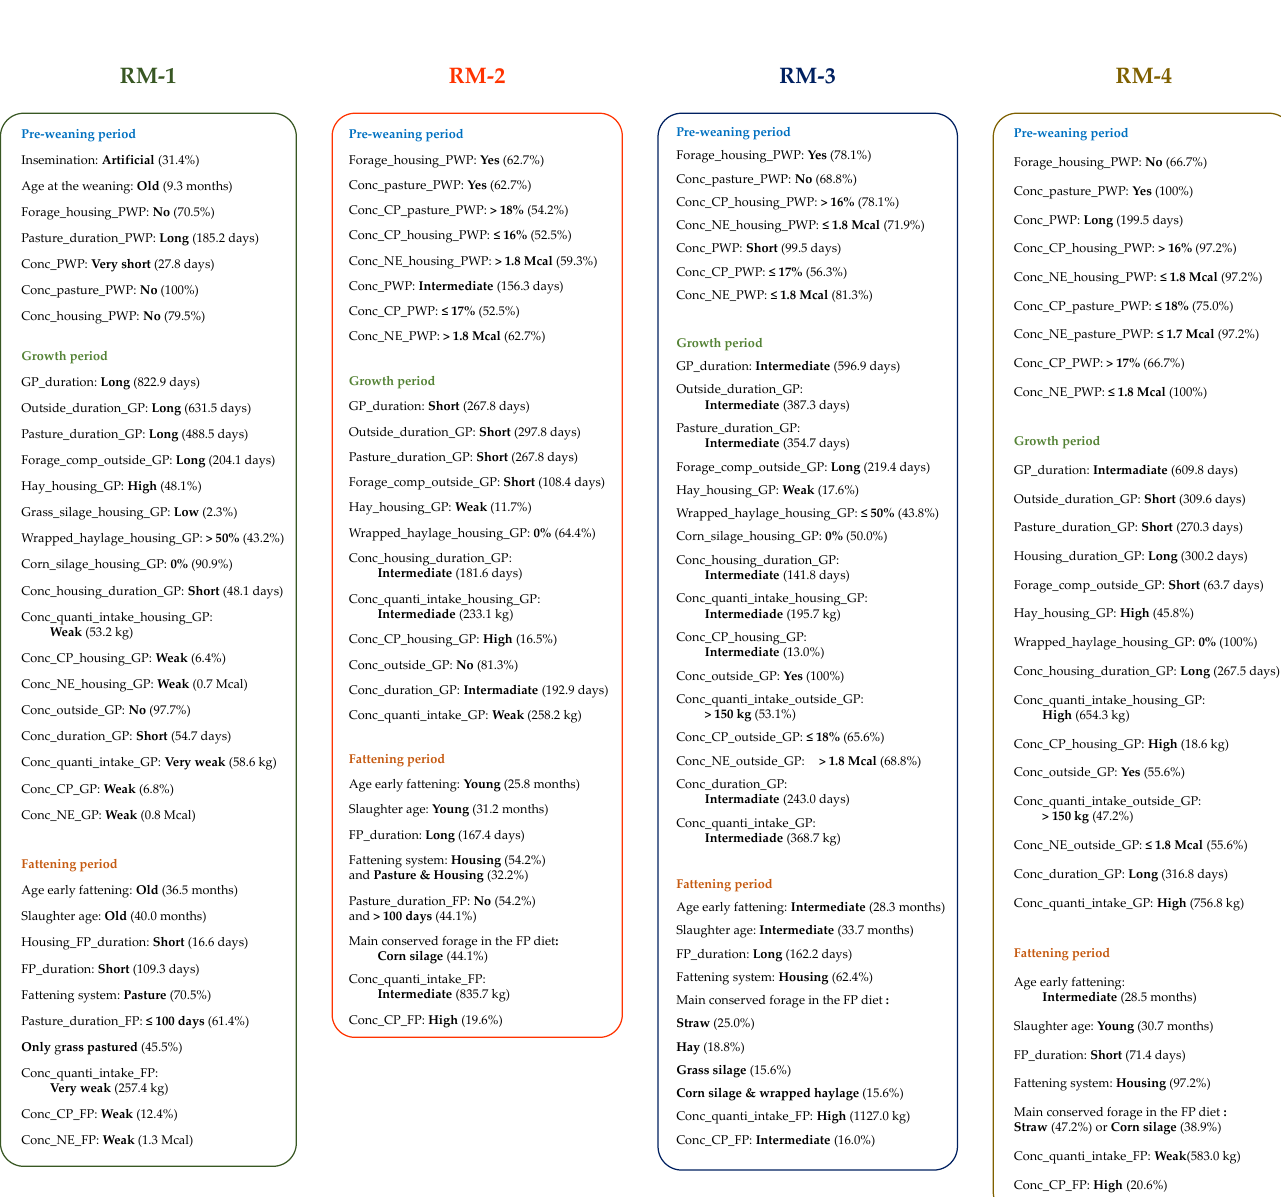
RM-2, RM-3, and RM-4 were not significantly different ( p > 0.05). Our results are in during the heifers’ whole life as RM-1 (Figure 2) produced carcasses with low conformation. As previously observed, the combination of different rearing practices [22] or